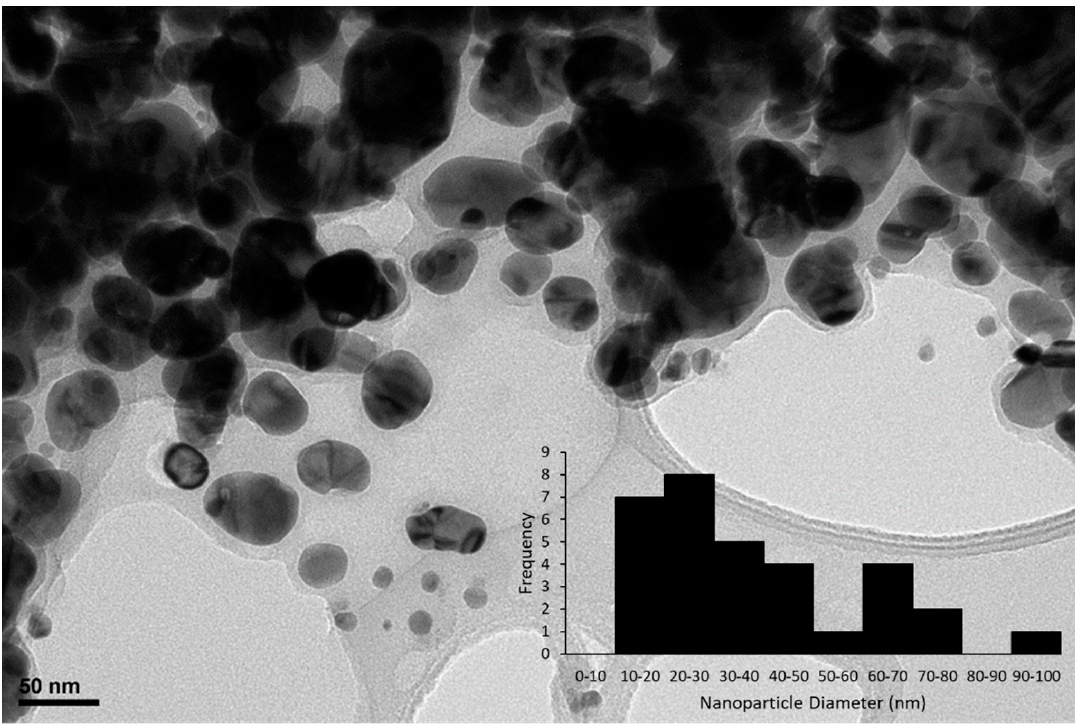
Figure 1. TEM micrographs of the Ag nanoparticle network. A silver nanoparticle network (AgNPN) is shown dispersed in solution and is depicted with a scale bar of 50 nm in the bottom left. A Histogram of nanoparticle diameter is inset in the bottom right. Average particle size is 36 ± 21.5 nanometers.